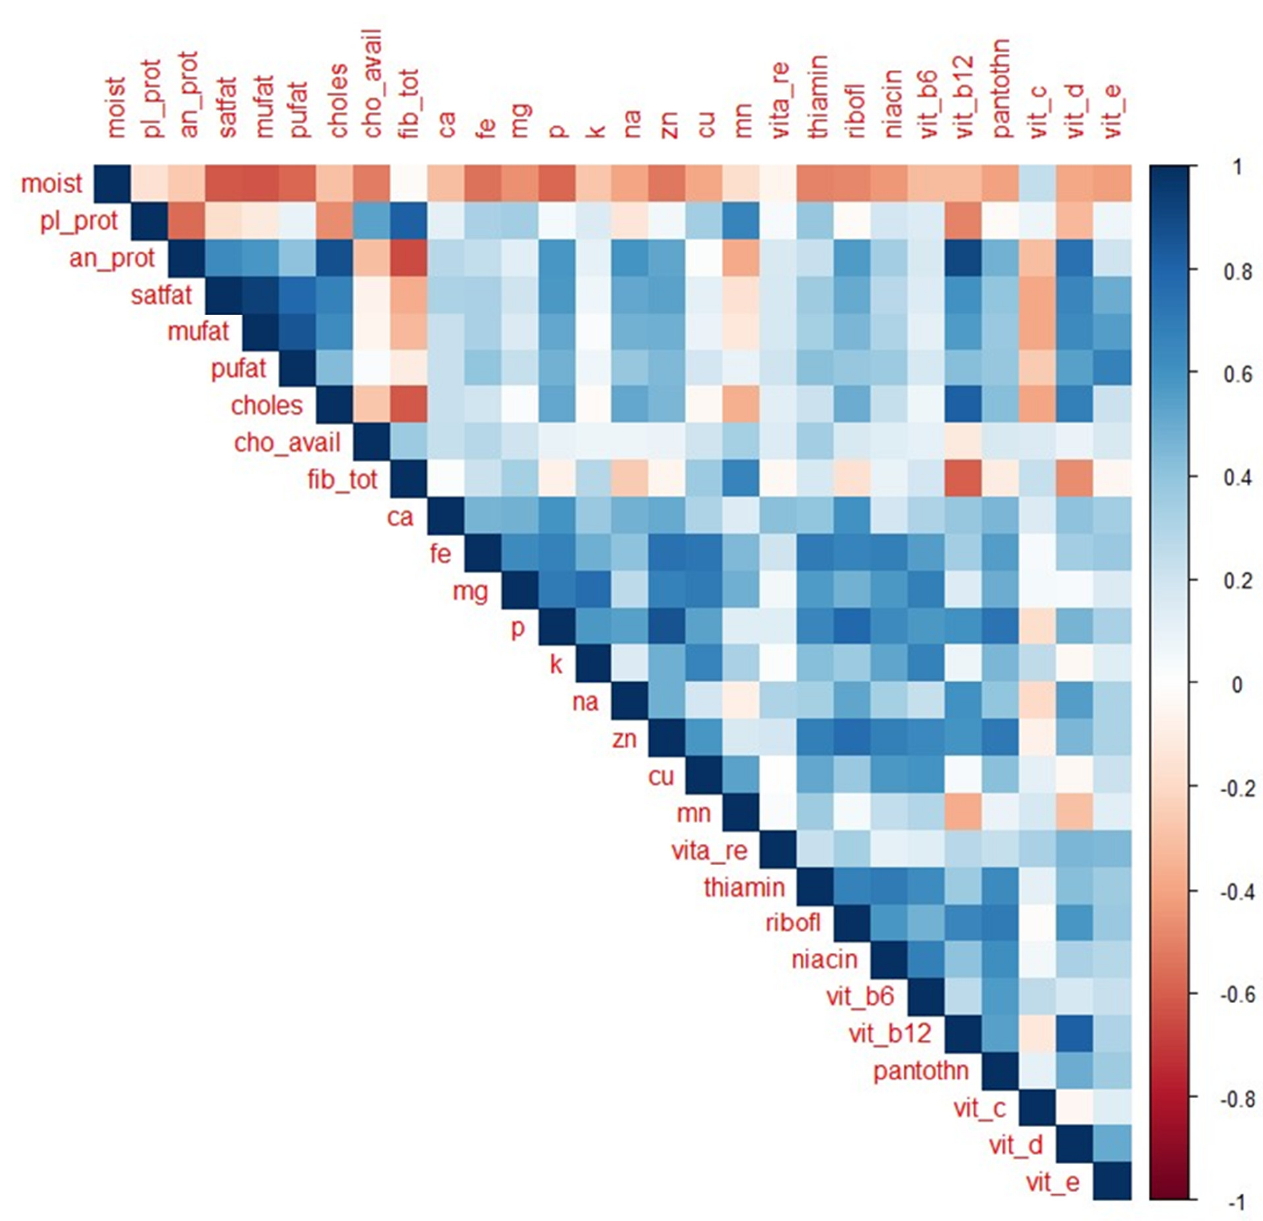
Figure 2. Spearman’s rank correlations between the nutrients.